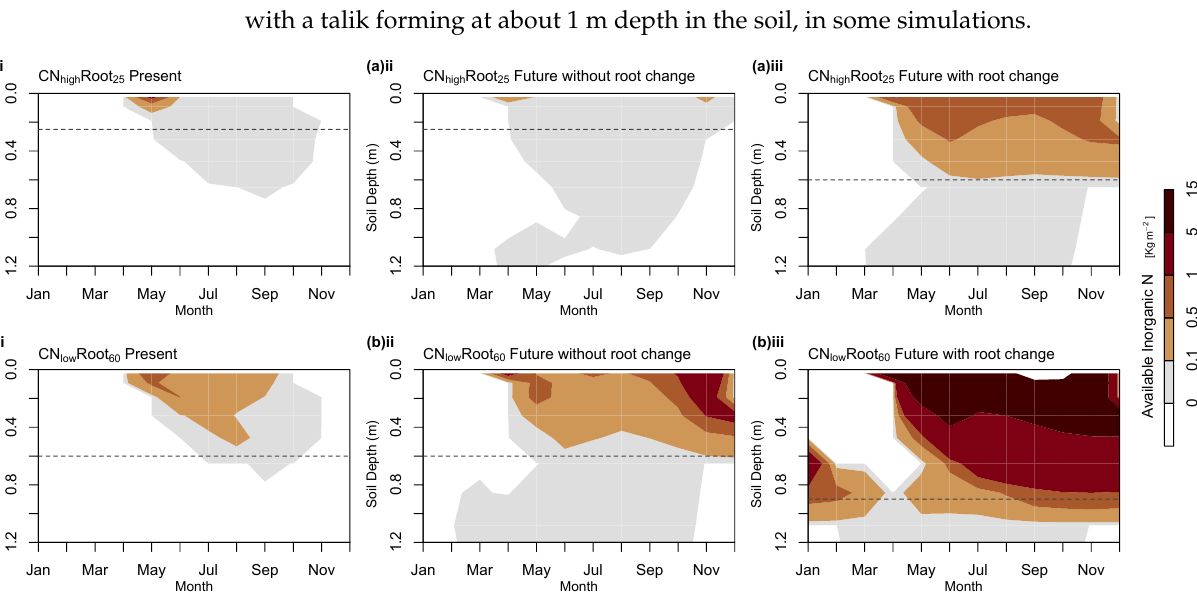
Figure 7. Inorganic nitrogen available to plant species with ( a ) i CN high Root 25 for 2000–2010 (present) and ( a ) ii 2090–2100 (future under a RCP8.5 scenario), along with ( a ) iii CN high Root 60 for 2090–2100 (future under a RCP8.5 scenario). The bottom row shows ( b ) i CN low Root 60 for 2000–2010 (present) and ( b ) ii 2090–2100 (future under a RCP8.5 scenario), along with ( b ) iii CN low Root 90 for 2090–2100 (future under a RCP8.5 scenario). The horizontal dotted line shows the maximum rooting depth. The grey shaded area represents the thawed